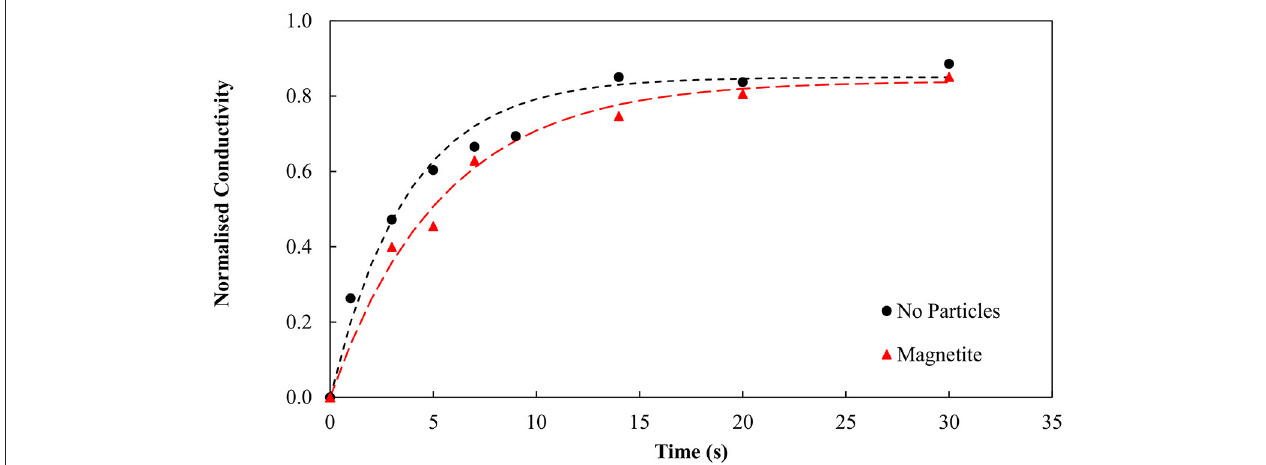
FIGURE 3 | Emulsion degradation over time for systems containing no particles and magnetite particles.